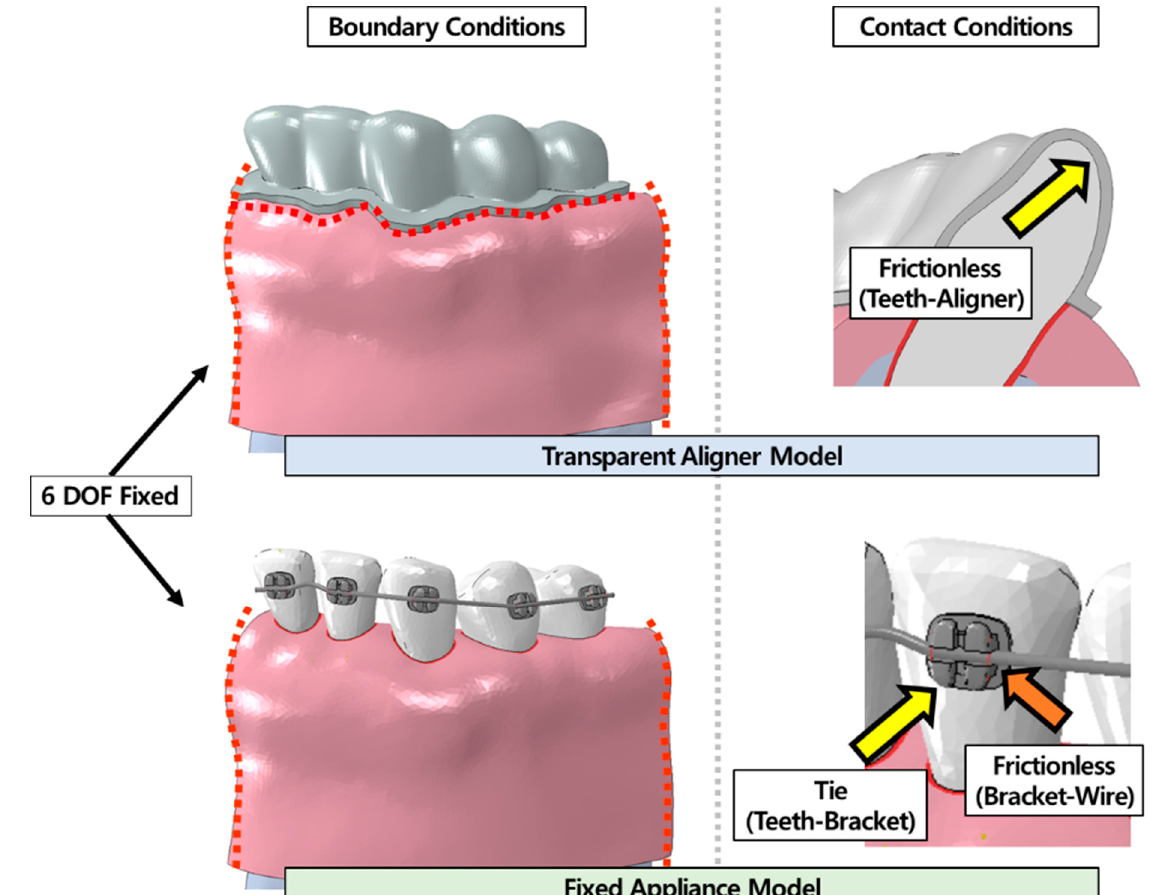
Figure 12. Boundary and contact conditions in orthodontic treatment analysis. On both sides (red dashed line) of the tooth-alveolar bone model with a transparent aligner and fixed appliance constrained to six degrees of freedom. In the transparent aligner model, the bottom surface was set so that there was no movement. The contact condition was frictionless between the teeth and aligner, as in the verification analysis. In the fixed appliance model, a tie condition was applied for the teeth and bracket, while the bracket and arch-wire contact was considered frictionless.